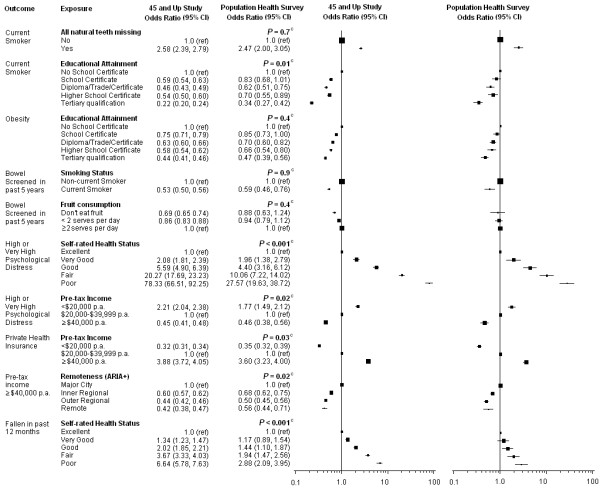
Odds Ratios a by study where either the exposure or outcome or both variables were only moderately comparable across the 45 and Up Study and the NSW PHS b. ARIA+, Accessibility Remoteness Index of Australia; CI, Confidence Interval; NSW, New South Wales; p.a, per annum; PHS, Population Health Survey. a Adjusting for age, sex and remoteness. b Black squares represent ORs with area inversely proportional to the sample size contributing to the OR and the corresponding line represents the 95% confidence interval. c P-value from Wald chi-square test: testing for a difference between the two studies for the specific exposure-outcome pair